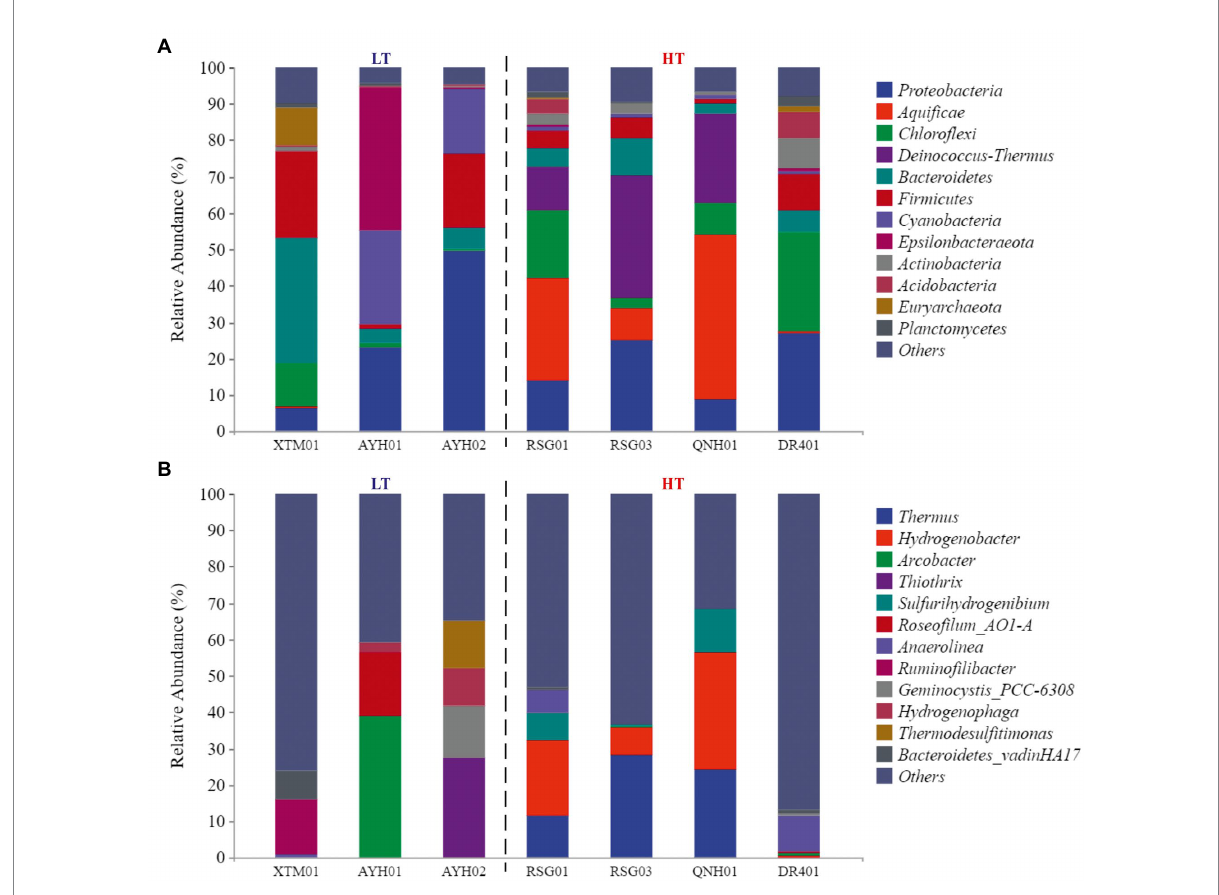
FIGURE 3 The phylum composition (A) and genus composition (B) of the groundwater bacterial